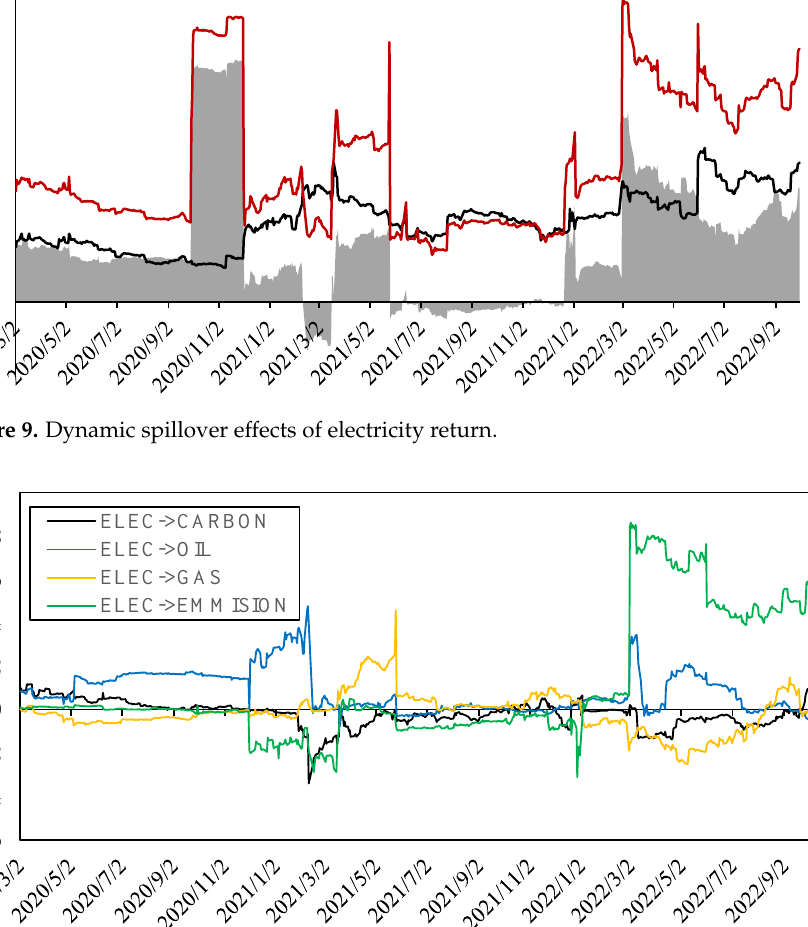
Figure 10. Dynamic net spillover effects from electricity return to other indicators.